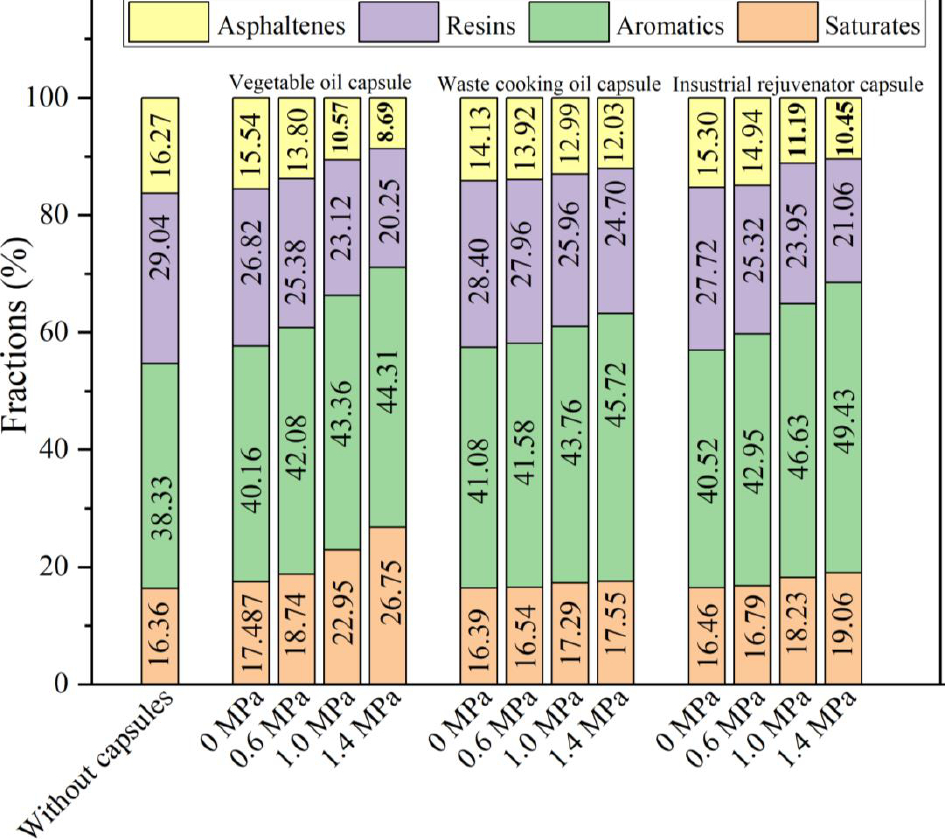
Figure 12. The SRAR fractions of the extracted asphalt binders.